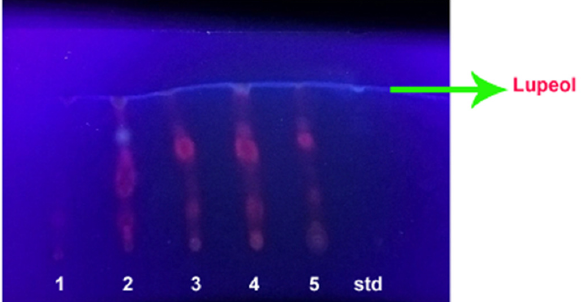
FigFigFigFigureureureure 3333. TLC chromatogram of selected samples of C. nutans . Track 1&2: In vivo plant (absolute control), Track 3: In vitro plant (control), Track 4: In vitro YE-treated plant, Track 5: In vitro chitosan- treated plant, Track 6: Standard (Lupeol) Table 3Table 3Table 3Table 3. R f values of the bands corresponding to lupeol in selected samples of C. nutans in TLC Sl. No.Sl. No.Sl. No.Sl. No.